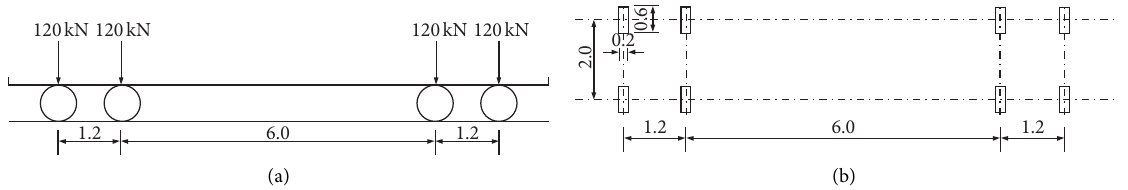
Figure 8: Fatigue load model (unit: m).